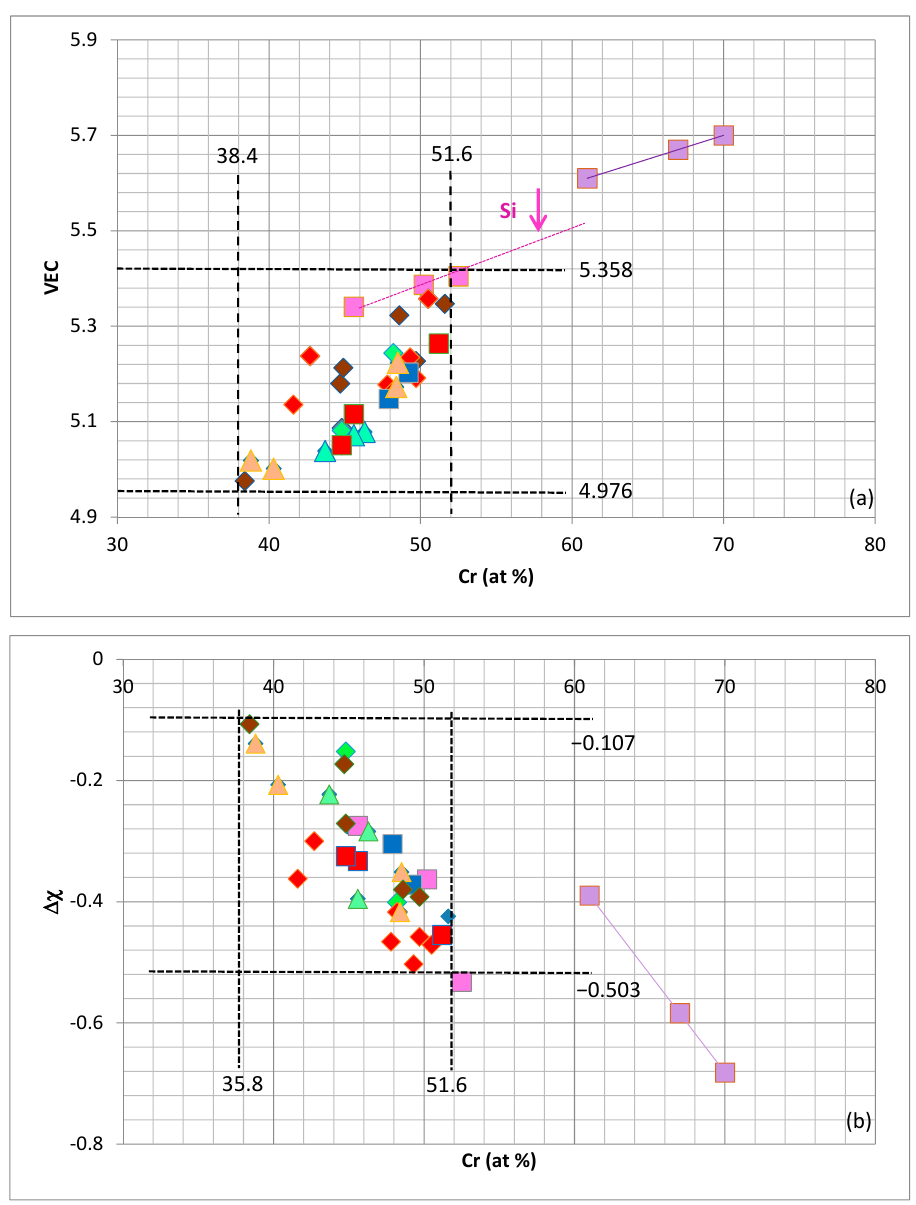
Figure 4. Laves phase maps of VEC ( a ) and ∆χ ( b ) versus Cr concentration in the Laves phase. Lavender, pink, blue, red, light green and dark orange squares represent the same data as in Figure 2a. Triangles represent (Nb,Ti)(Cr,Si,Al,Sn) 2 and (Nb,Ti,Mo,Hf)(Cr,Si,Al,Sn) 2 (light orange), (Nb,Ti)(Cr,Si,Al,Ge) 2 (light green); diamonds represent (Nb,Mo)(Cr,Si,Al) 2 (rose), (Nb,Ti,Ta)(Cr,Si,Al) 2 , (Nb,Ti,Hf)(Cr,Si,Al) 2 , (Nb,Ti,Mo,Hf)(Cr,Si,Al) 2 (red), (Nb,Ti,Hf)(Cr,Si,Ge) 2 (light green), (Nb,Hf)(Cr,Si,Sn) 2 and (Nb,Ti,Hf)(Cr,Si,Sn) 2 (dark orange), (Nb,Ti,Mo,W,Hf)(Cr,Si,Sn) 2 (brown).